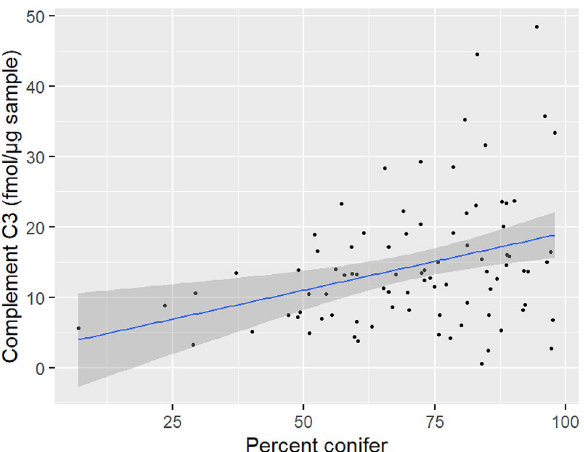
Figure 5. Estimated expression (solid blue line) of complement C3 related to percent conifer. Grey shade is 95% confidence band and closed symbols are the raw data of protein expression. Figure was created using R